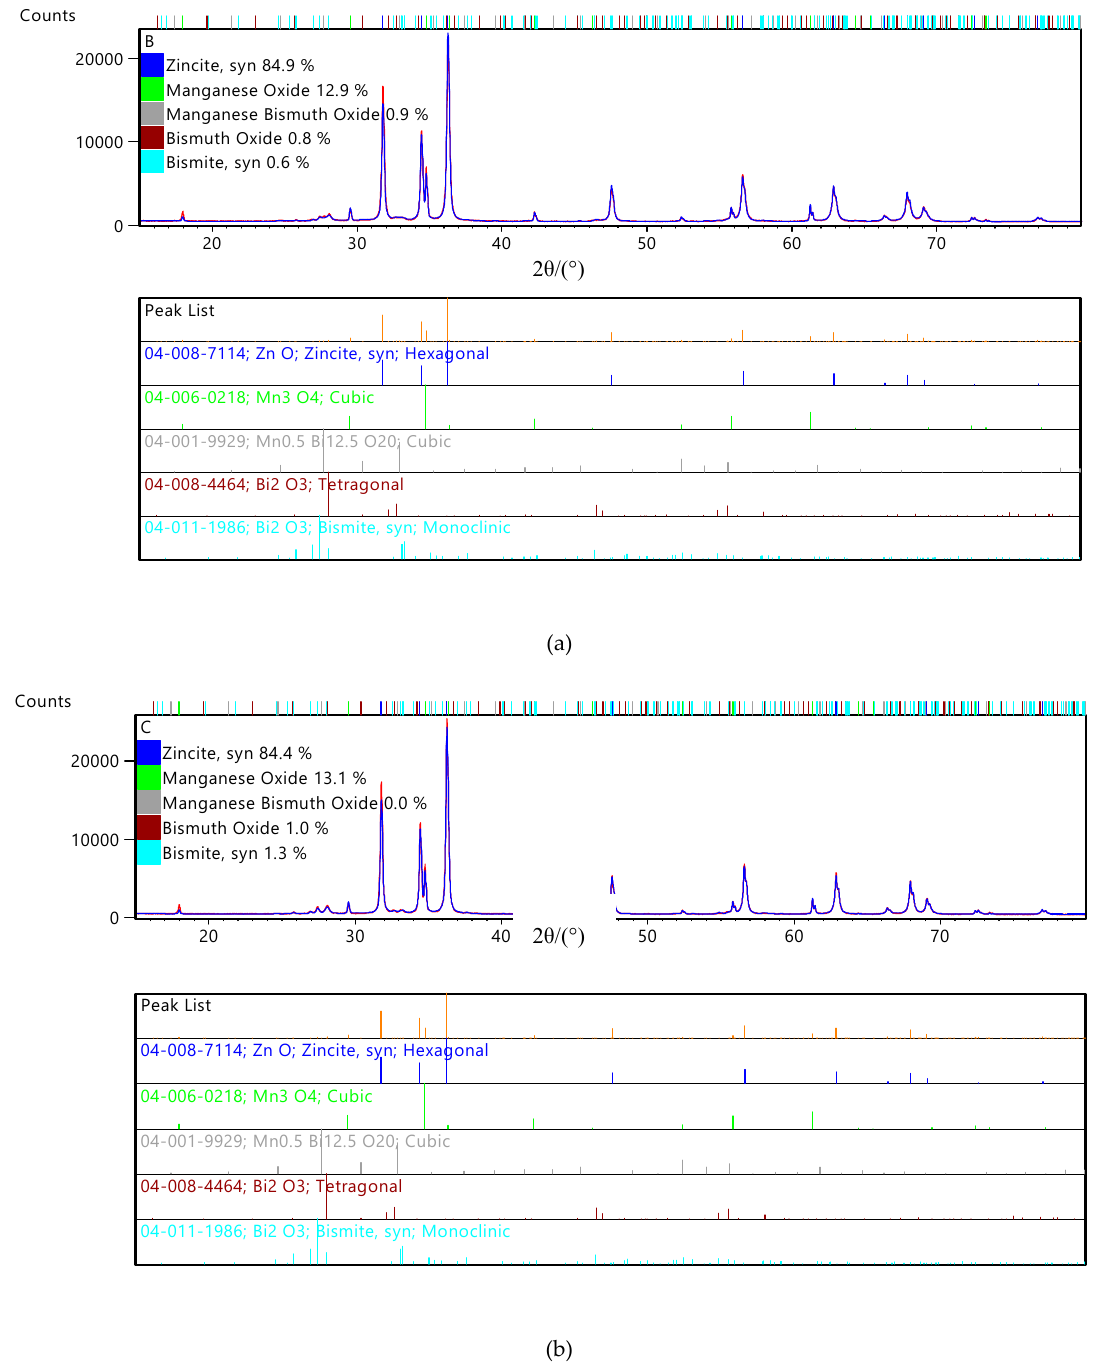
Figure 9. XRD diffraction results of the ZnO varistors before ( a ) and after ( b ) the impulses. Figure 10a,b illustrate the SEM images of the ZnO varistors, before and after the impulses, with a resolution of 80 μ m. It was observed that after the impulses, the grain sizes became smaller, while the white areas increased. The differences in the microstructures of the materials in the ZnO varistors indicate that the multiple lighting impulse currents led to the ZnO grains becoming smaller, along with the grain boundary growth.